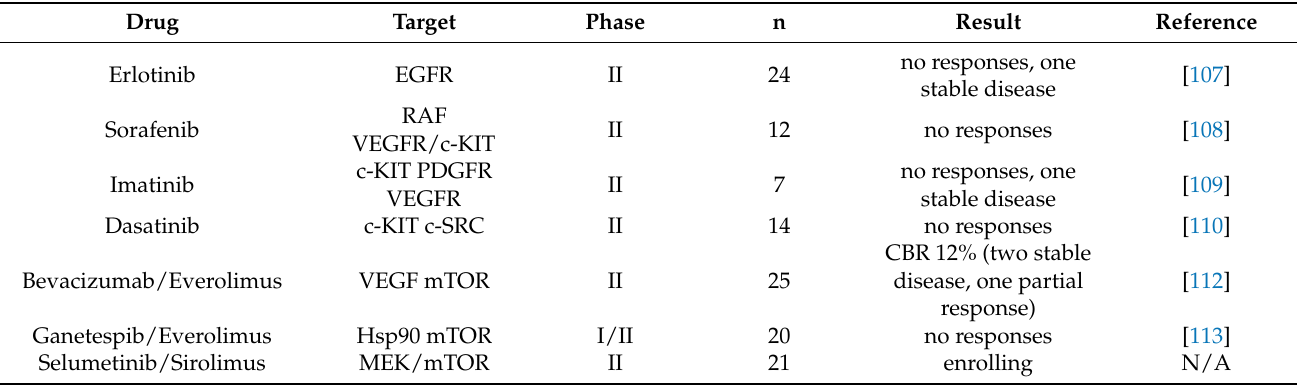
Table 2. Registered clinical trials for targeted therapy of